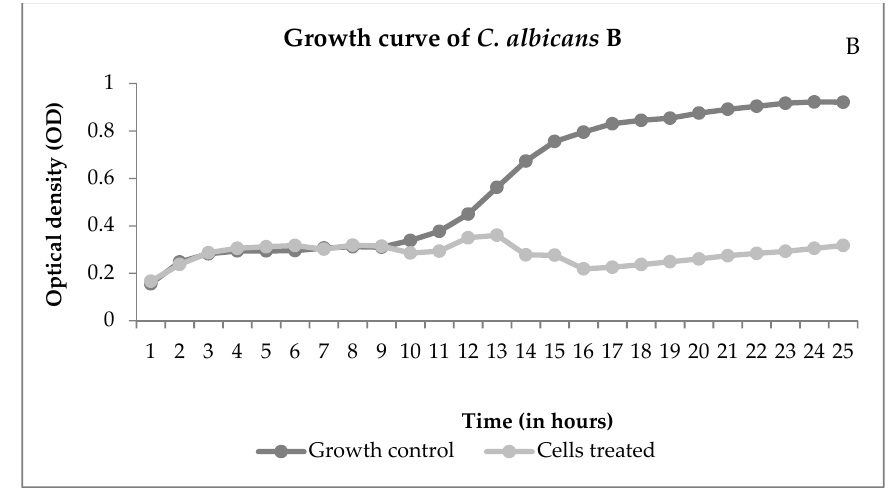
Figure 4. Growth curves of Mucor ramosissimus ( A ) and Candida albicans B ( B ), controls, and cells treated with NECC at MIC and room temperature (25 °C) .